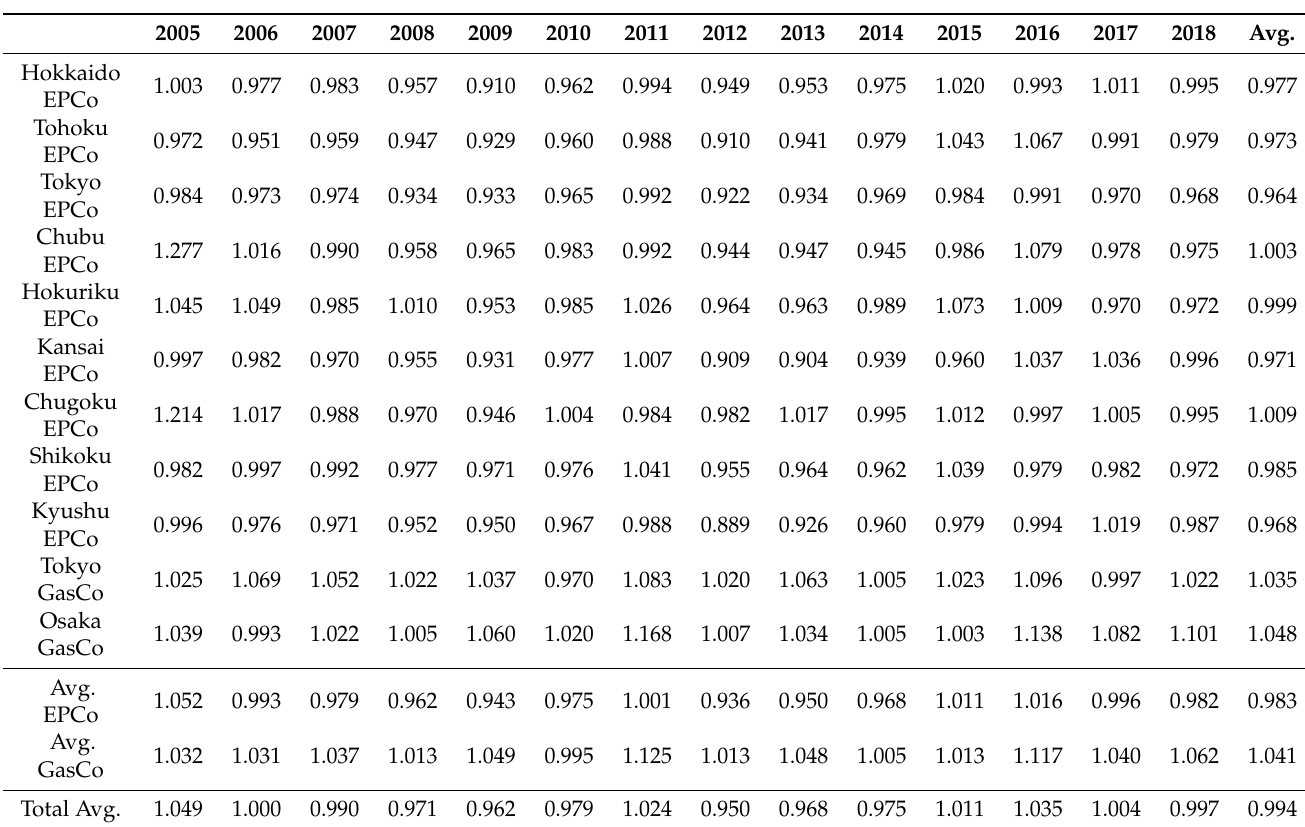
Table 4. Operational Index (WOI) of Utility Companies: Index